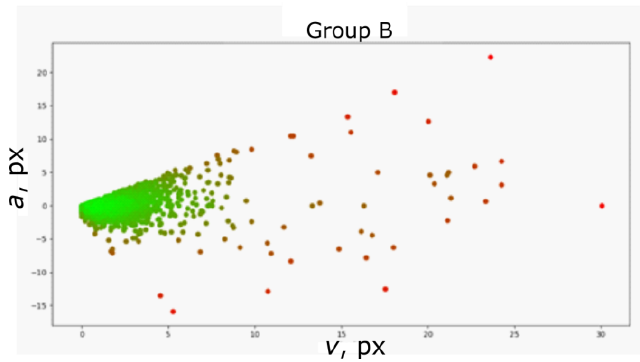
Fig. 7. Video 1, group B